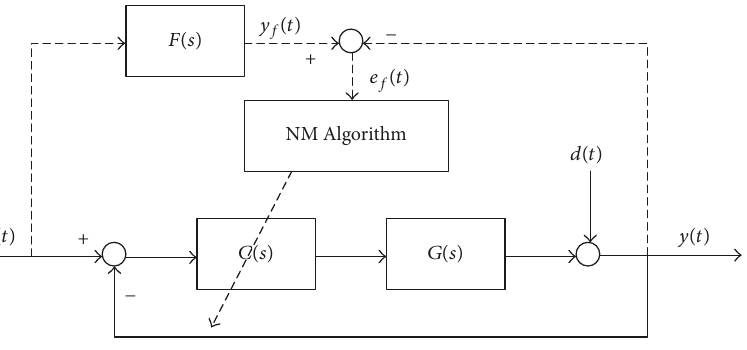
Figure 9: Tuning